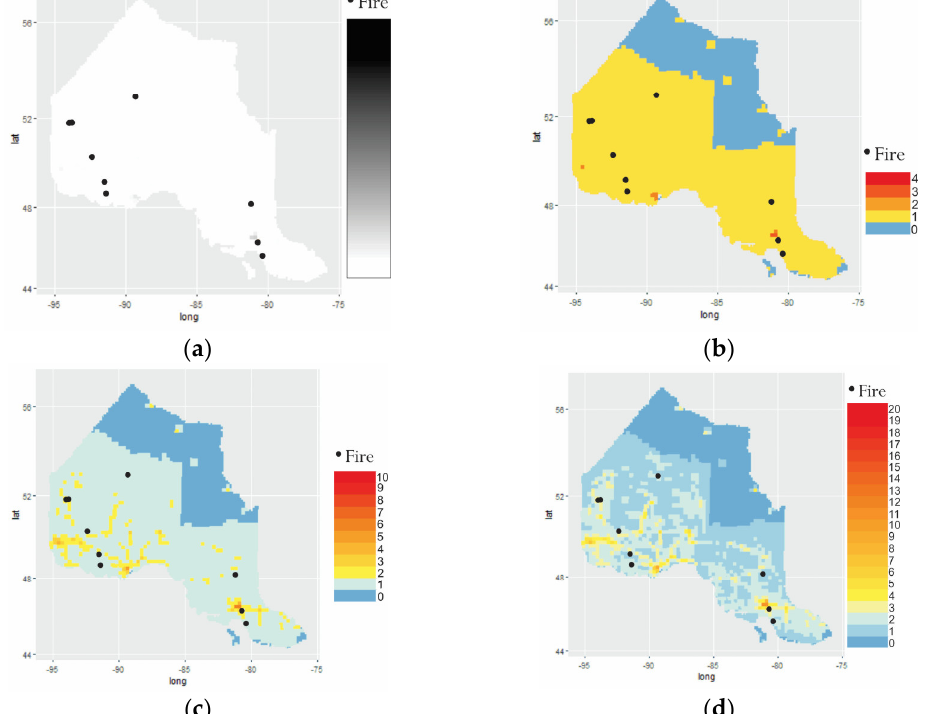
Figure 5. The human-caused fire occurrence prediction of June 10, 2018, mapped using the catego- rization and colouring schemes indicated in the legends. The black dots are the human-caused fires reported later that day. The scales range from zero to 3 fires/cell: ( a ) the baseline scheme (Table 3), which shows little useful information; ( b ) 4 + 1 categories; ( c ) 10 + 1 categories; ( d ) 20 + 1 categories. The additional category in ( b ), ( c ) and ( d ) are for a “no forecast model” or true zero. Using more categories and hues greatly increases the information portrayed but makes matching the colour to the legend more difficult. The spatial pattern in ( d ) corresponds with roads and settlements.